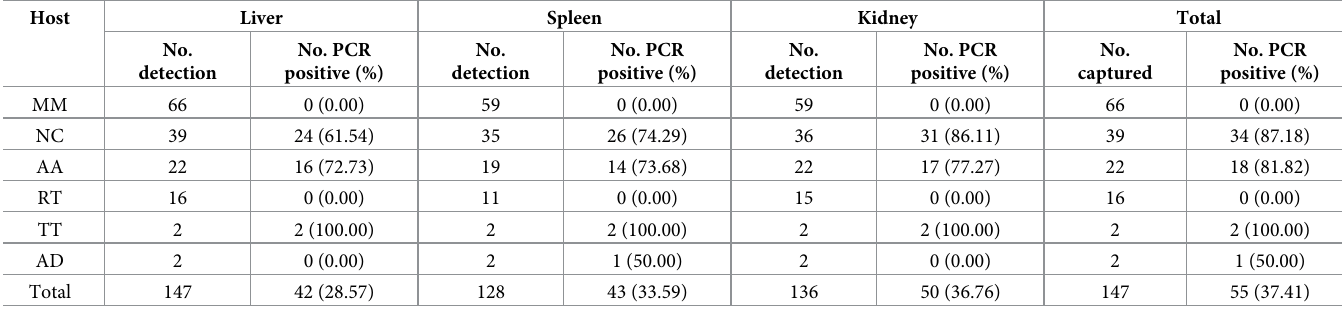
Table 1. Positivity rate of Bartonella infection in different tissues of small